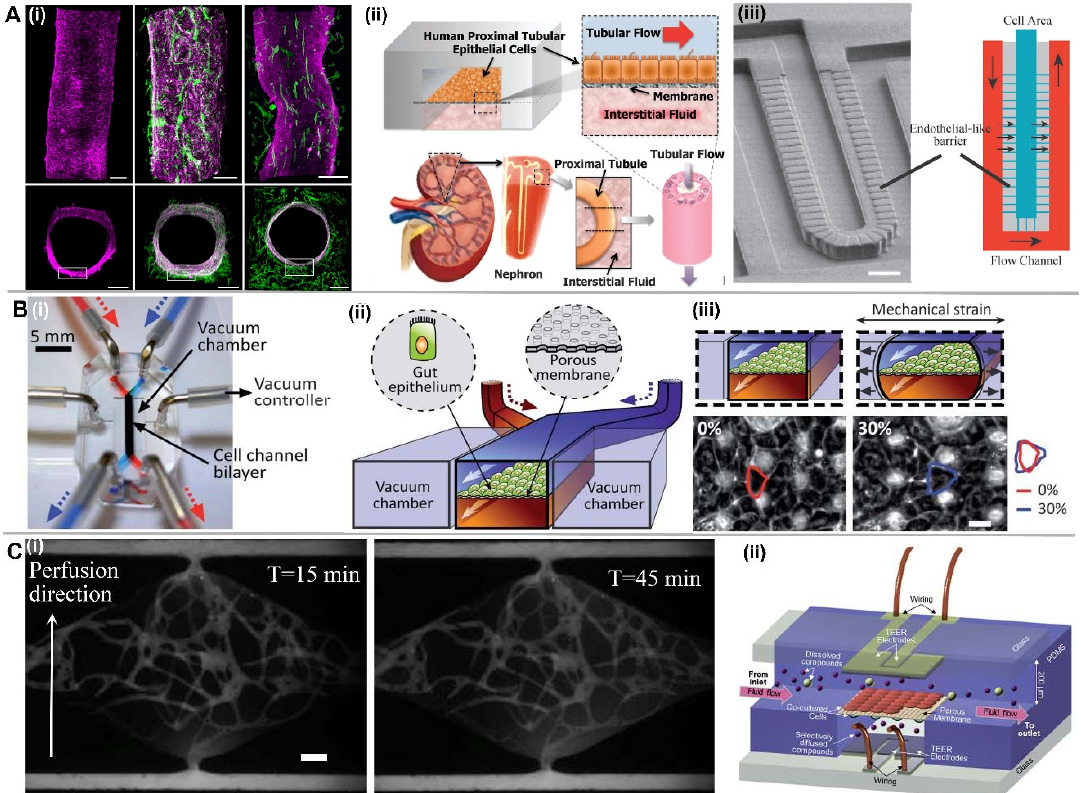
Figure 5. Selective vascular barrier property of different organ chips, construction with porous membrane and permeability characterization methods. ( A ) Microvascular with different structure and selective barrier function in different organ-on-a-chip. ( i ) BBB with tight cell-cell junctions. Fluorescence confocal micrographs of the engineered brain microvessel from human brain microvascular endothelial cells (left), and co-culture with pericytes (middle) and astrocytes (right). Scale bar, 200 µ m. Adapted by permission from Reference [95], under the Creative Commons Attribution License 2016. ( ii ) Schematic of a human kidney proximal tubule-on-a-chip in an attempt to mimic the natural architecture, tissue–tissue interface, and dynamically active mechanical microenvironment of the living kidney proximal tubule. Adapted by permission from Reference [96], copyright Royal Society of Chemistry 2013. ( iii ) Schematic of the liver-on-a-chip design that resembles a liver sinusoid, including the endothelial-like barrier layer. Scale bar, 50 µ m. Adapted by permission from Reference [99], copyright John Wiley and Sons, Inc. 2007. ( B ) Human gut-on-a-chip. ( i ) Photographic image of the chip prototype. ( ii ) A monolayer of gut epithelial cells is cultured on the flexible porous ECM-coated membrane in the middle of the central microchannel. Vacuum chambers are designed parallel to the channels that can apply mechanical strain to the cell layer. ( iii ) Schematics (top) and phase contrast images (bottom) of intestinal monolayers cultured within the gut-on-a-chip in the absence (left) or presence (right) of mechanical strain (30%; arrow indicated direction) exerted by applying suction to the vacuum chambers. Scale bar, 20 µ m. Adapted by permission from Reference [106], copyright Royal Society of Chemistry 2012. ( C ) Vascular permeability characterization. ( i ) Permeability coefficient calculation by measuring perfusion fluorescent solutes across vessel lumen wall over time. Scale bar, 100 µ m. Adapted by permission from Ref. [26], copyright Royal Society of Chemistry 2016. ( ii ) Schematic of a multi-layered microfluidic device design with incorporated electrode for internal TEER measurement on a BBB model. Adapted by permission from Reference [93], copyright Royal Society of Chemistry 2012.